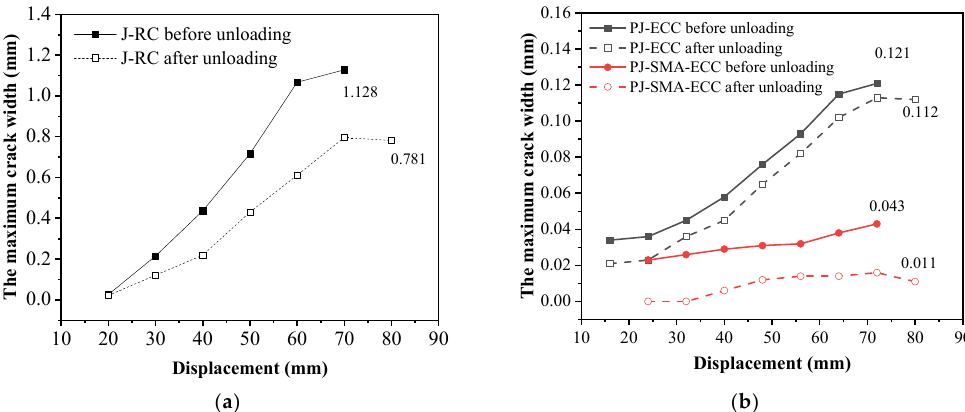
Figure 15. The maximum crack width before and after unloading of each cycle load for specimens. Note: The crack widths of specimens J-RC, PJ-ECC, and PJ-SMA-ECC with a displacement of 80 mm are measured fifteen minutes after the test ended. ( a ) J-RC; ( b ) PJ-ECC and PJ-SMA-ECC. The crack closing ratio of all the specimens is plotted in Figure 16. Compared with the other two specimens, Specimen PJ-SMA-ECC exhibited superior crack self-healing ability. That is because the super-elastic SMA fibers can automatically repair cracks after unloading. At the early stage of loading, the cracks in the joint zone of Specimen PJ-SMA- ECC were almost completely closed. However, the crack width gradually increased and the crack closing ratio decreased to 60% with increasing displacement. This may have re- sulted from the limitation of self-healing efficiency of the SMA-ECC materials caused by increasing crack width [48]. Fifteen minutes after the entire test ended, the R of PJ-SMA- ECC had a slight increase; this is probably because the super-elastic effect of SMA fibers needs a buffer time to maximize its self-healing capacity after unloading. Figure 16. The crack closing ratio in the joint zone. 4.2. Ultrasonic Pulse Test 4.2.1. Testing Method The ultrasonic pulse test is an effective method for detecting internal defects and damages to concrete/cementitious materials by non-metallic ultrasonic pulse instruments [49]. To further analyze and compare the self-healing performance of Specimens PJ-ECC